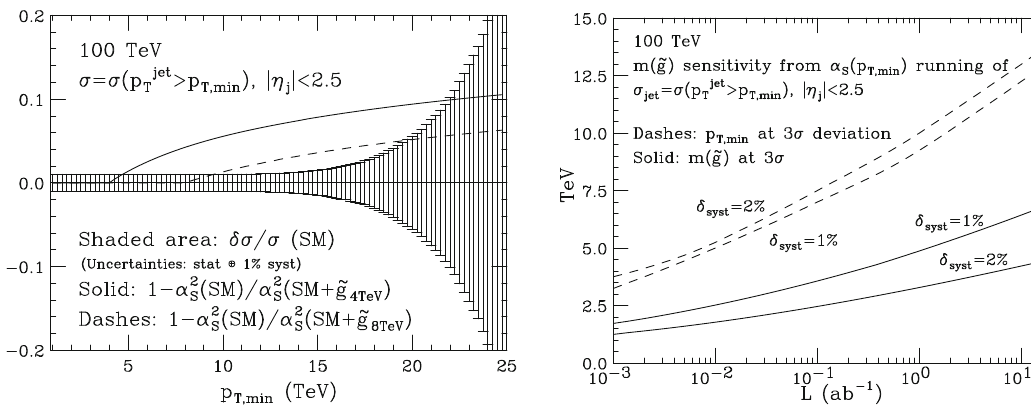
Fig. 5.5 Left plot: combined statistical and 1% systematic uncertain- ties, at 30 ab − 1 , vs p T threshold; these are compared to the rate change induced by the presence of 4 or 8 TeV gluinos in the running of α S .